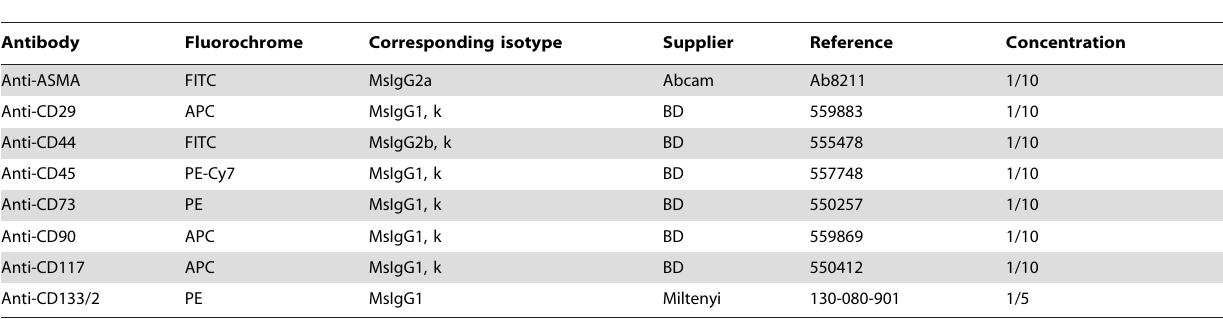
Table 3. Antibodies used for the phenotypic characterization of ADHLSCs and HSCs by flow cytometry.